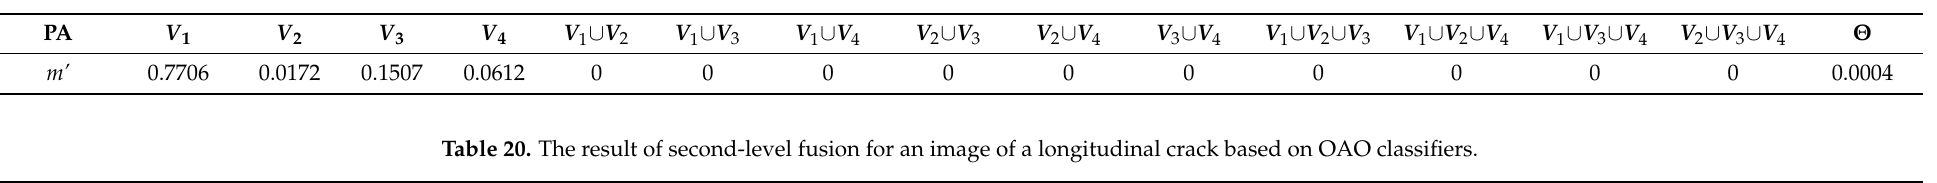
Table 19. The result of second-level fusion for an image of without a crack based on OAO classifiers.